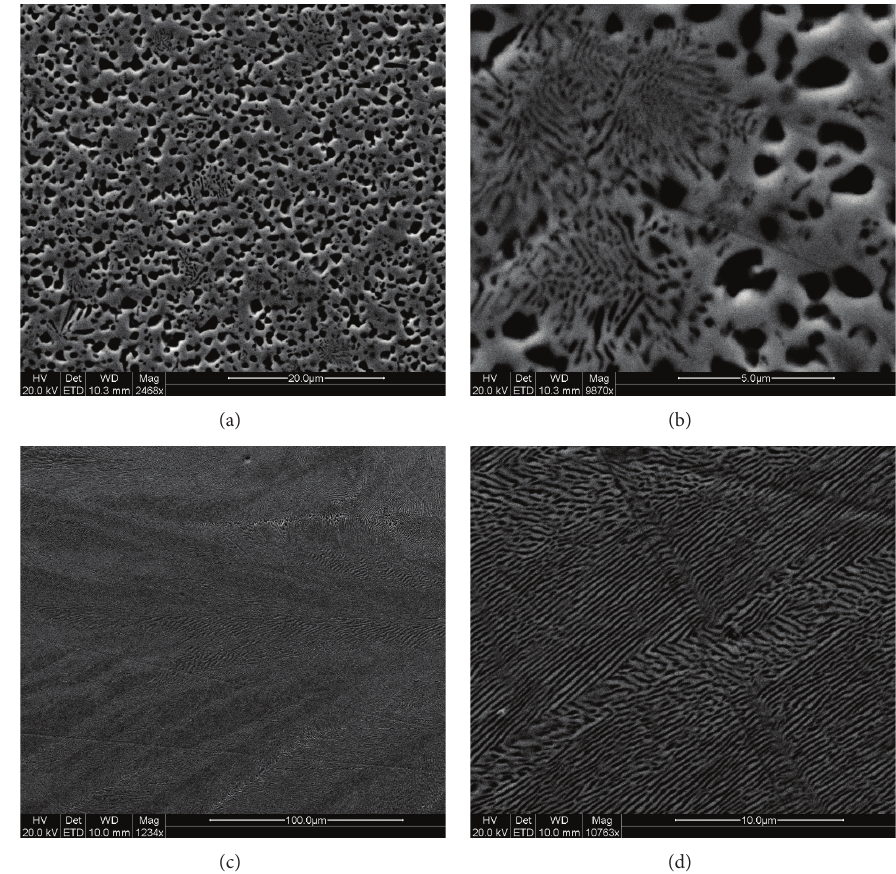
Figure 2: SEM images of sintered Ag72Cu powder at 725 ∘ C (a, b). Localized melting can be clearly observed. SEM images at 1200x and 10000x of the beaded material clearly showing the material was melted and squeezed out (c, d).